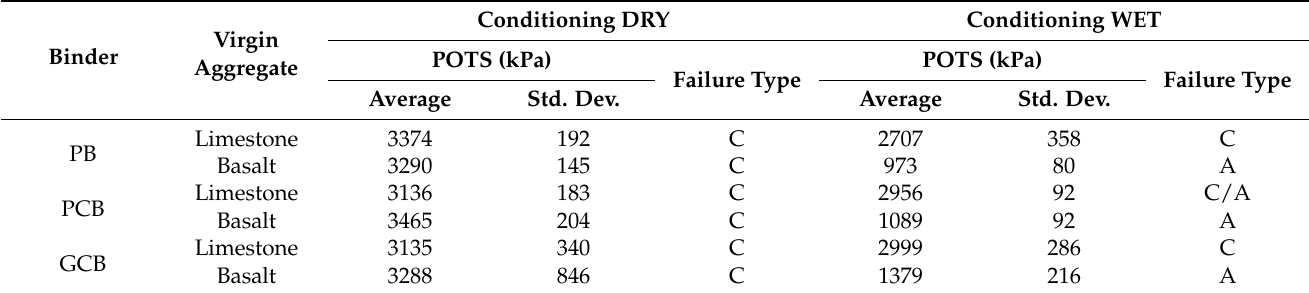
Table 8. BBS testing results for systems with virgin aggregate.